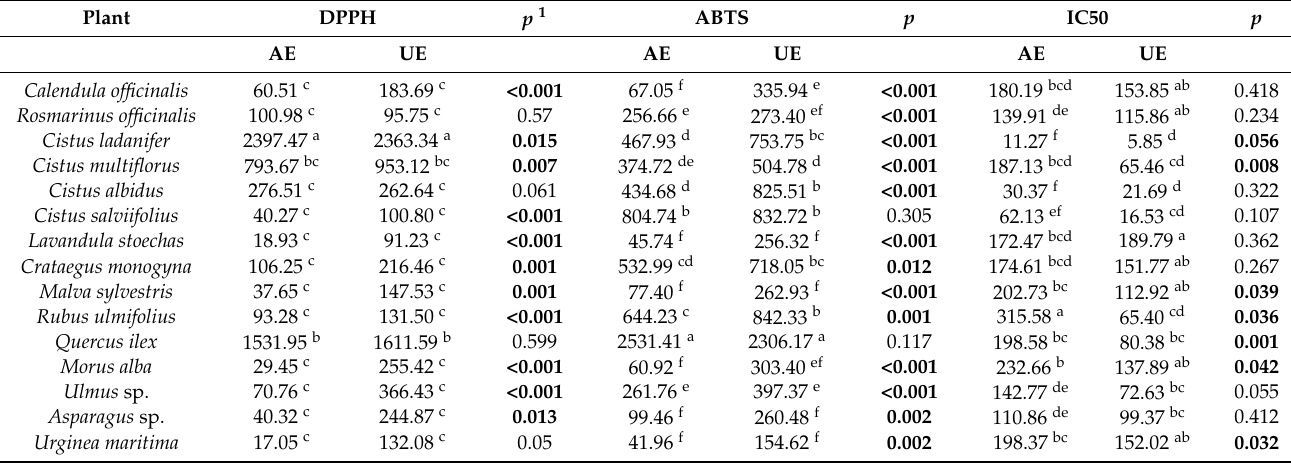
Table 2. Antioxidant activity (DPPH and ABTS) expressed in mg Trolox/100 g fresh plant and IC50 values ( µ g/mL) of ACE inhibitory activity of extracts for the different extraction methods (mechanical agitation (AE) and ultrasound-assisted extraction (UE) performed).